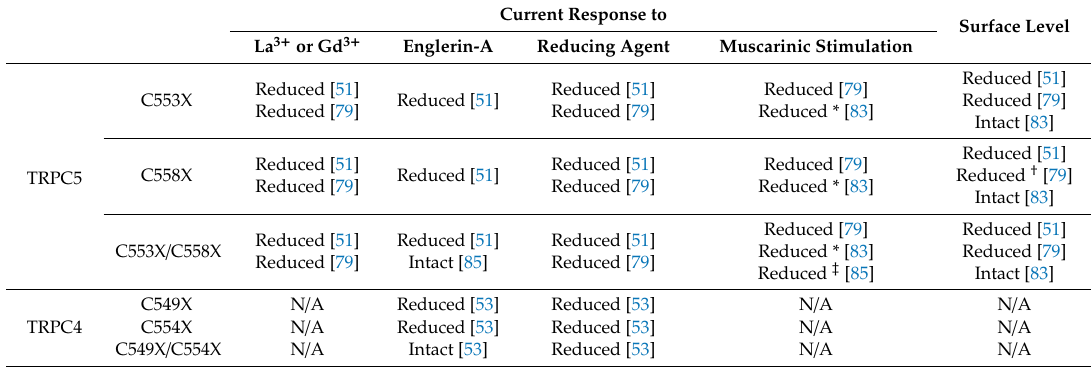
Table 4. Summary for accumulated results investigating outcome of cysteine